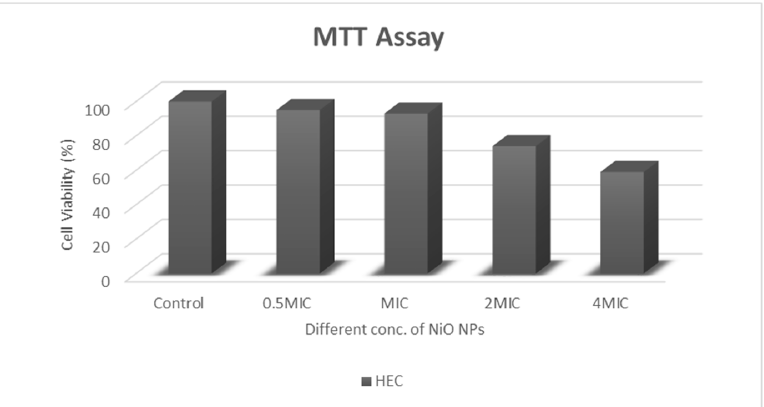
Figure 2. Cytotoxicity assessment of NiO NPs over normal human epithelial cell (HEC) line using the standard MTT.